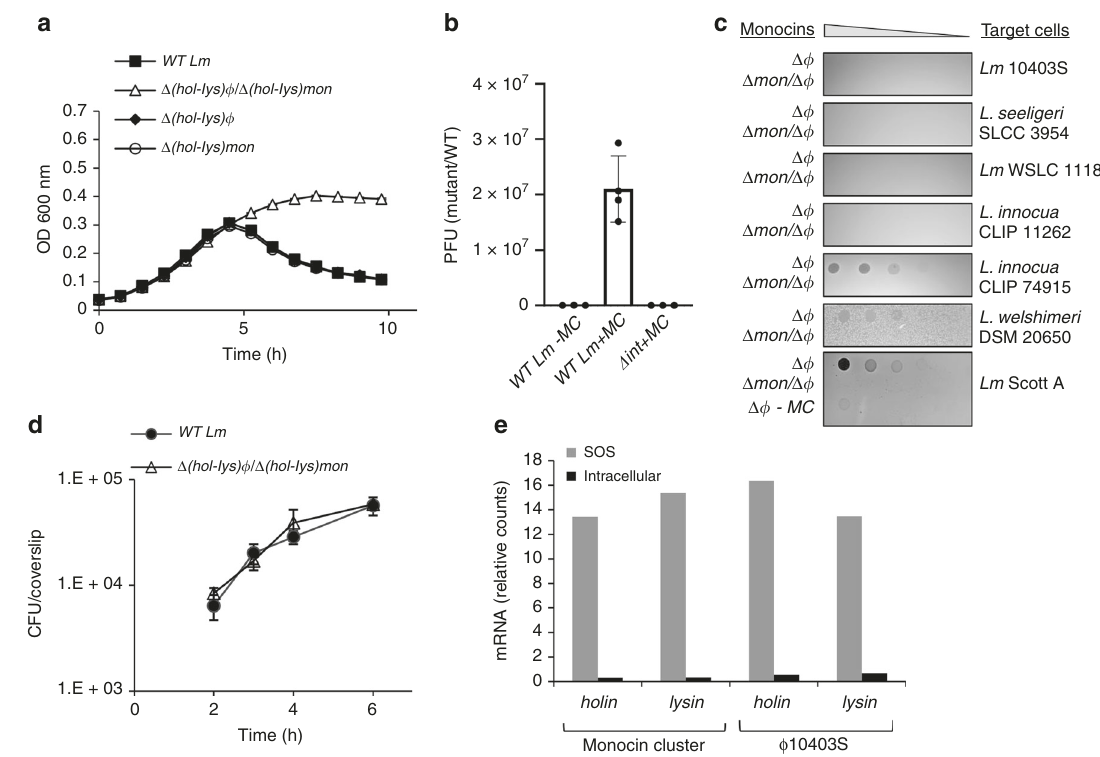
Fig. 1 The Lm 10403S strain harbors two functional lytic phage elements. a Growth analysis of WT Lm and mutants harboring deletions of the elements lysis modules; LMRG_01552 – 4 of ϕ 10403S ( Δ (hol-lys) ϕ ), and LMRG_02377-8 of monocin cluster ( Δ (hol-lys) mon ) or a mutant deleted of both lysis modules ( Δ hol-lys) ϕ / Δ (hol-lys) mon ), in the presence of mitomycin C (MC). Growth analysis of the mutants without MC is presented in Supplementary Fig. 1. Error bars represent the standard deviation of three independent biological repeats, and are hidden by the symbols. b Plaque forming assay of WT Lm and